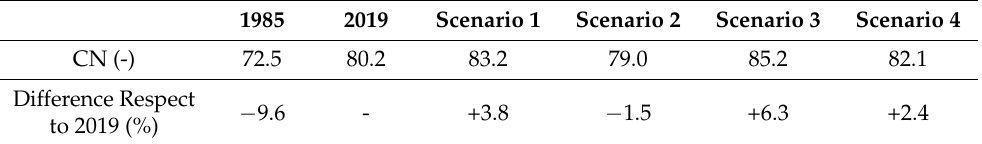
Table 4. CN values for Kakia and Esamburmbur sub-catchments in 1985, 2019 and in the assumed scenarios. The table reports also the differences with respect to the 2019